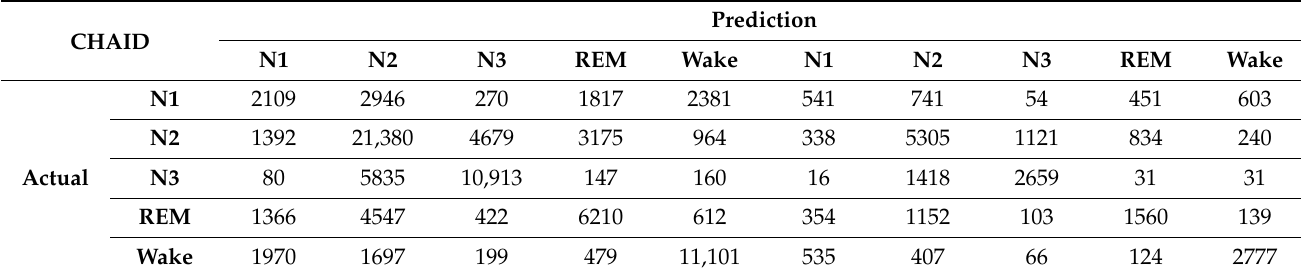
Table 6. Confusion matrix of the CHAID Model using training and testing datasets for the classifica- tion of EEG features of the sleep stages W, N1, N2, N-3, and R.